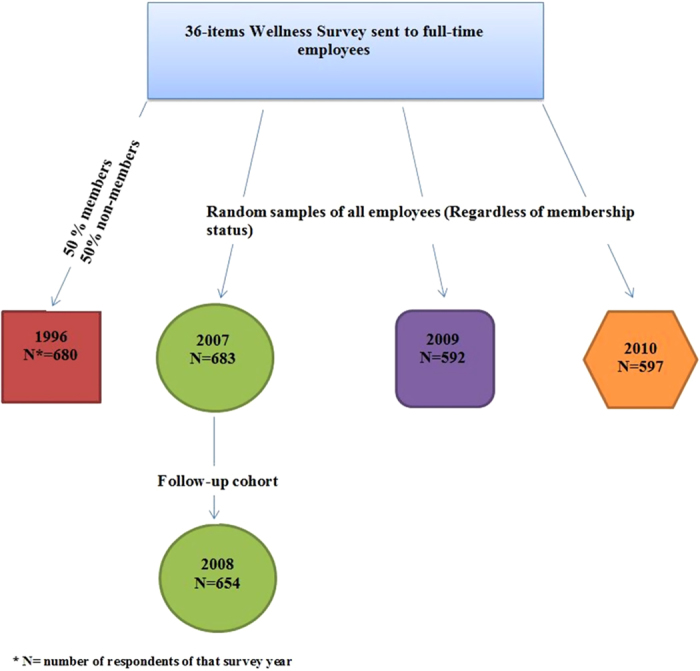
Flow diagram illustrates 5 surveys per year and number of respondents.